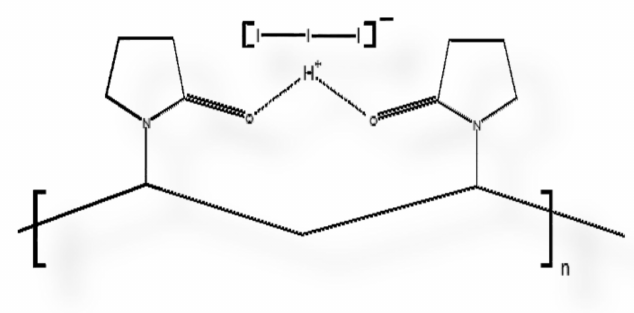
Figure 9. Scheme of polyvinylpyrrolidone (PVP) polymer backbone adhering triiodide ion (I 3 − ) through hydrogen bridge, resulting in PVP-I 2 , which is actually (PVP-I 3 −